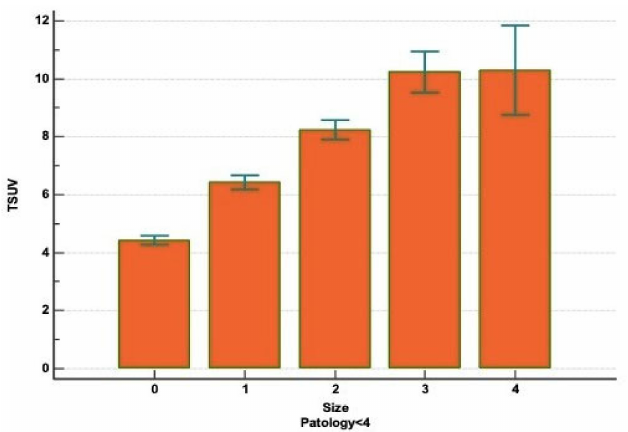
Figure 4. Correlation between SUVmax and tumor